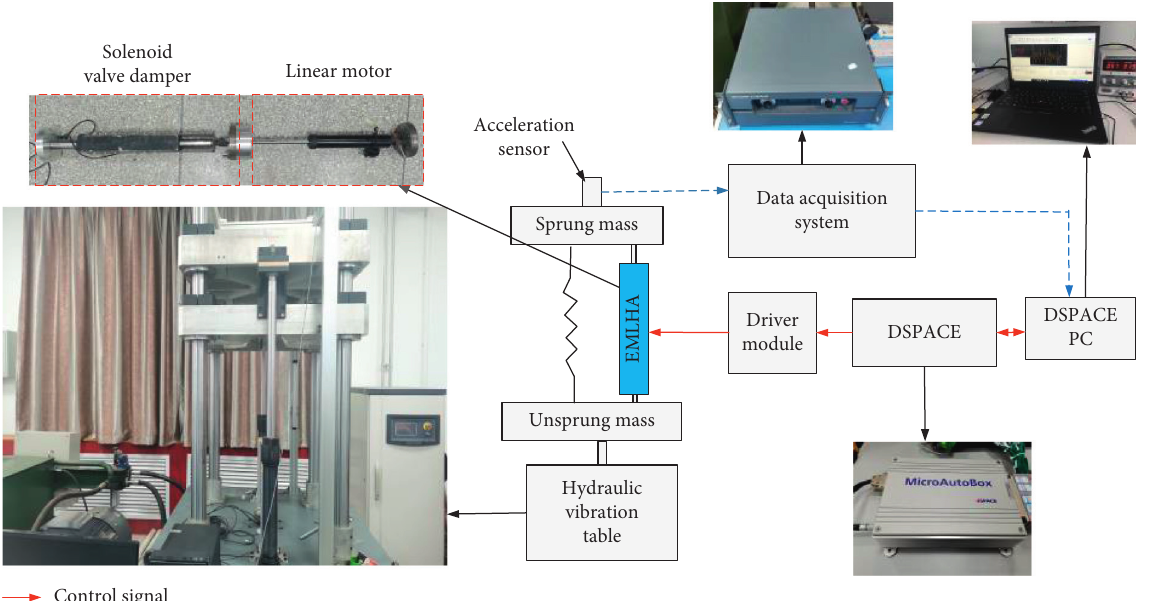
Figure 16: Schematic diagram of the test system.